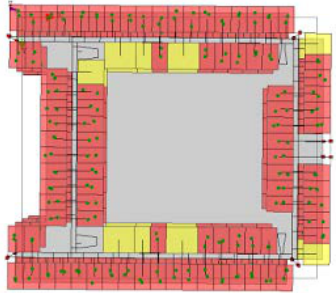
Figure 4. Importing of GIS database to GAMA Platform